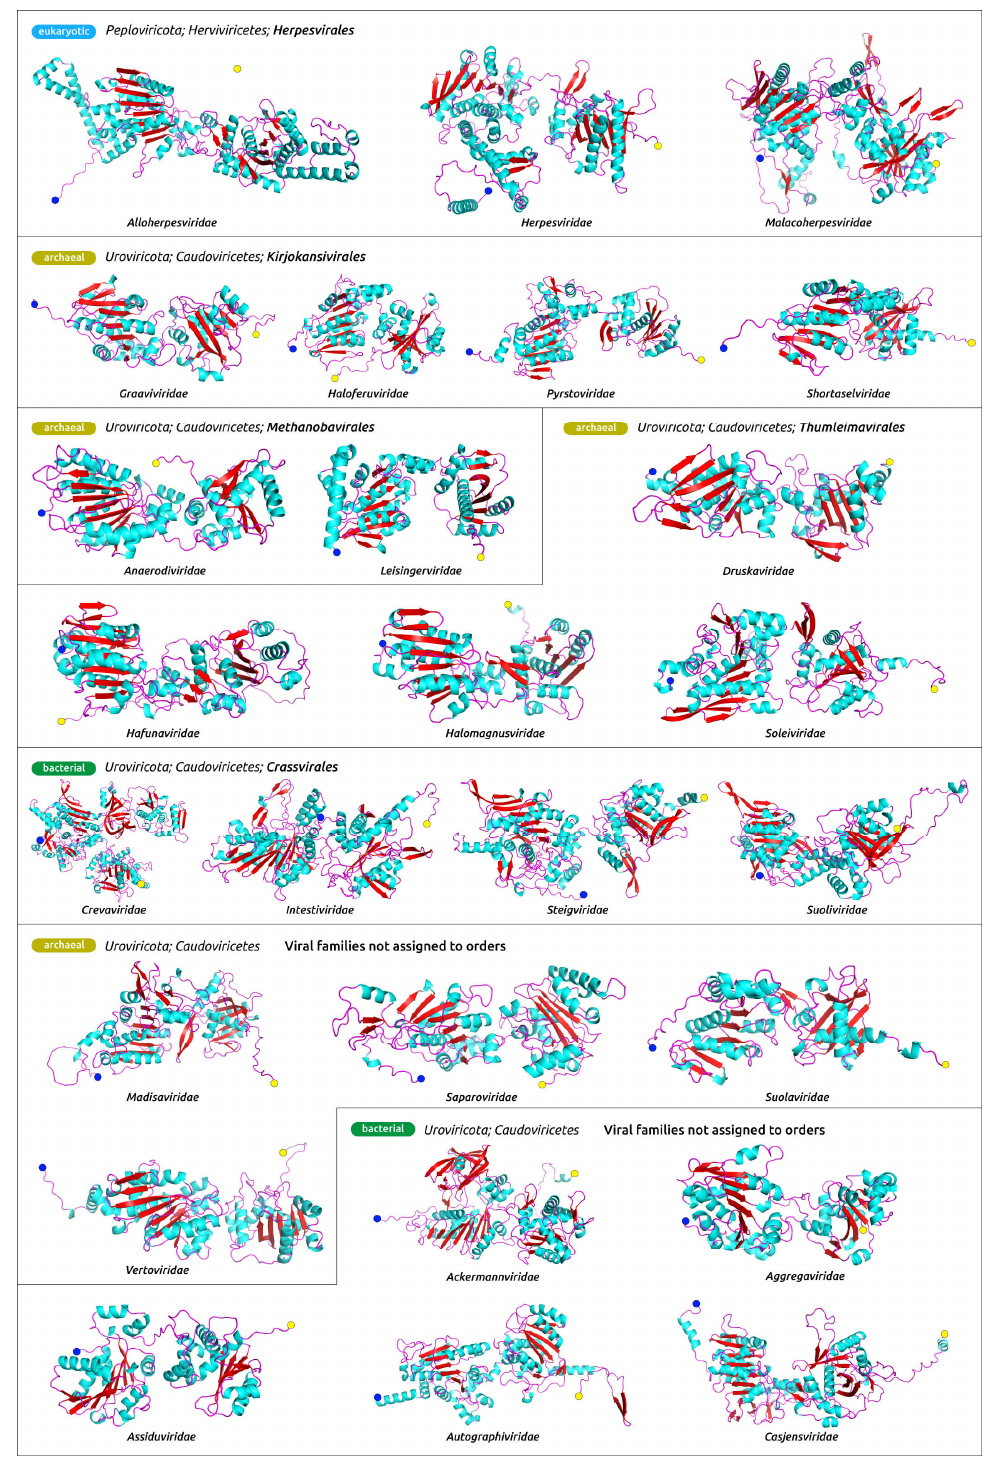
Figure 4. Structural models of the product of the whole genes encoding for the ATPase subunit of terminase in the genomes of representative viruses (Table 1), obtained with AlphaFold. The N-terminus is labelled with a blue circle and the C-terminus is labelled with a yellow circle. Other predicted terminase structures are shown in Supplementary Figure